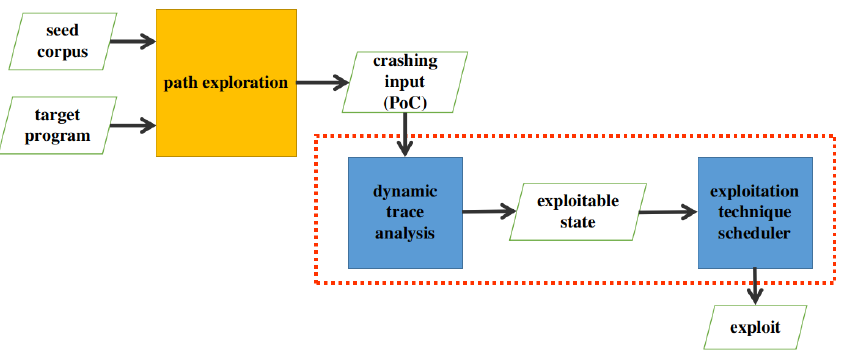
Figure 2. The general workflow of current AEG